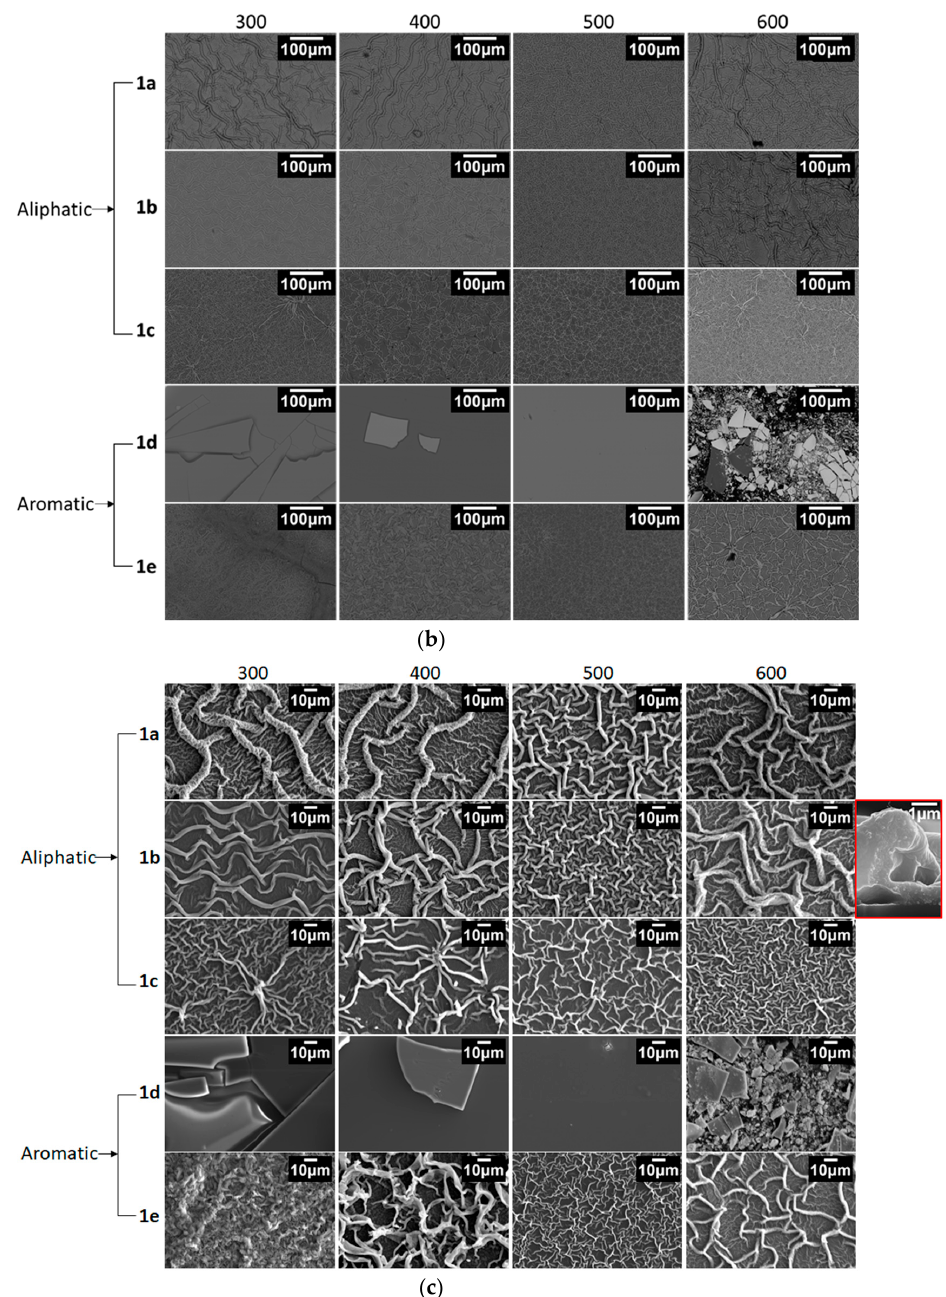
Figure 6. ( a ) Secondary-electron (topology) SEM images of the fi lms. ( b ) Backsca tt ered-electron (composition) SEM images of the fi lms. ( c ) Secondary-electron (topology) SEM images of the fi lms (higher magni fi cation). The insert corresponds to the cross-section of fi lm 1b annealed at 600 °C. Backsca tt ered electrons (Figure 6b) produce small contrast in all the analysed fi lms, indicating continuous layers with chemical uniformity at the microscopic scale for every sample. Only fi lms 1d exhibit a di ff erent behaviour, being cracked even at annealing tem- peratures as low as 300 °C. Although a very thin fi lm remains adhered to the substrate,